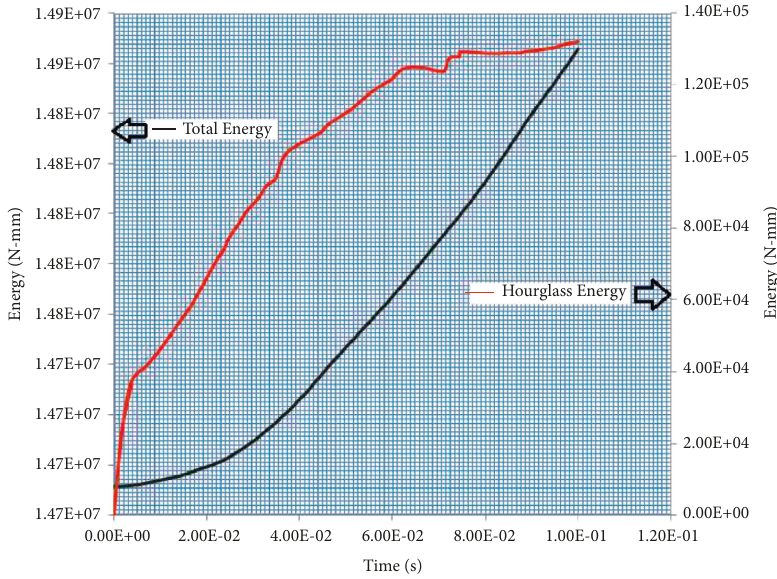
Figure 23: Ratio of